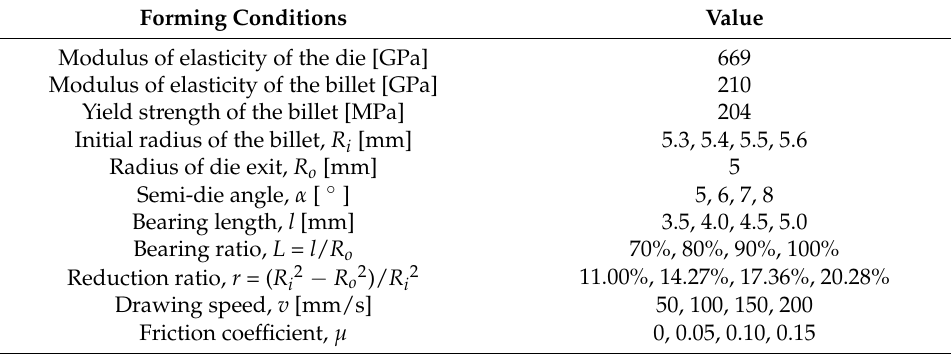
Figure 3. Forming parameters in a drawing process. Table 1. Forming parameters used in FE simulations.